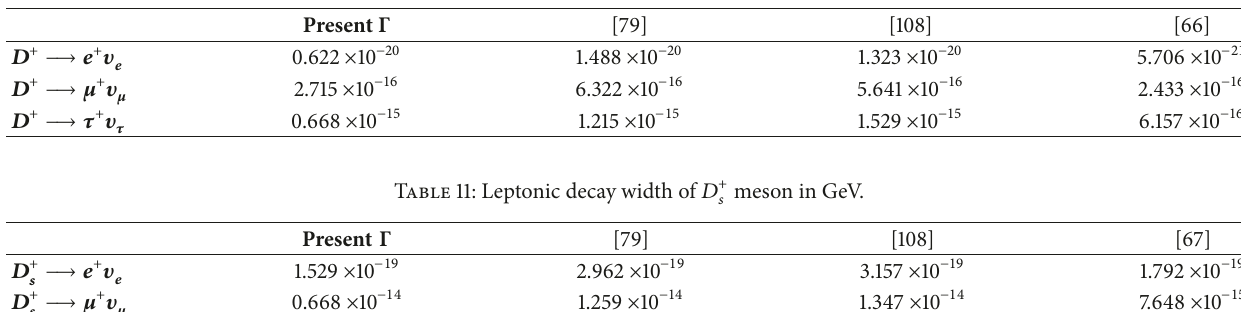
Table 10: Leptonic decay width of D + meson in GeV.